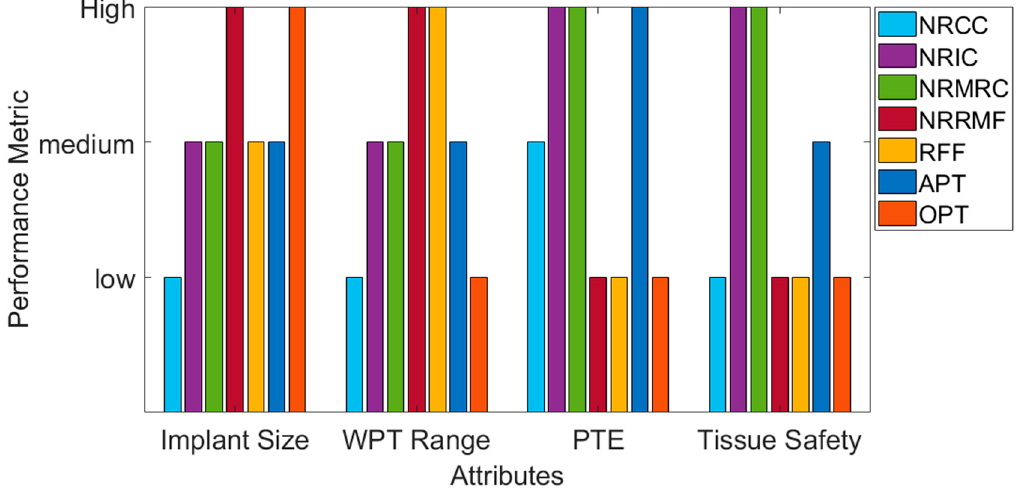
Figure 52. The abstract level figure of the performance of different WPT techniques.